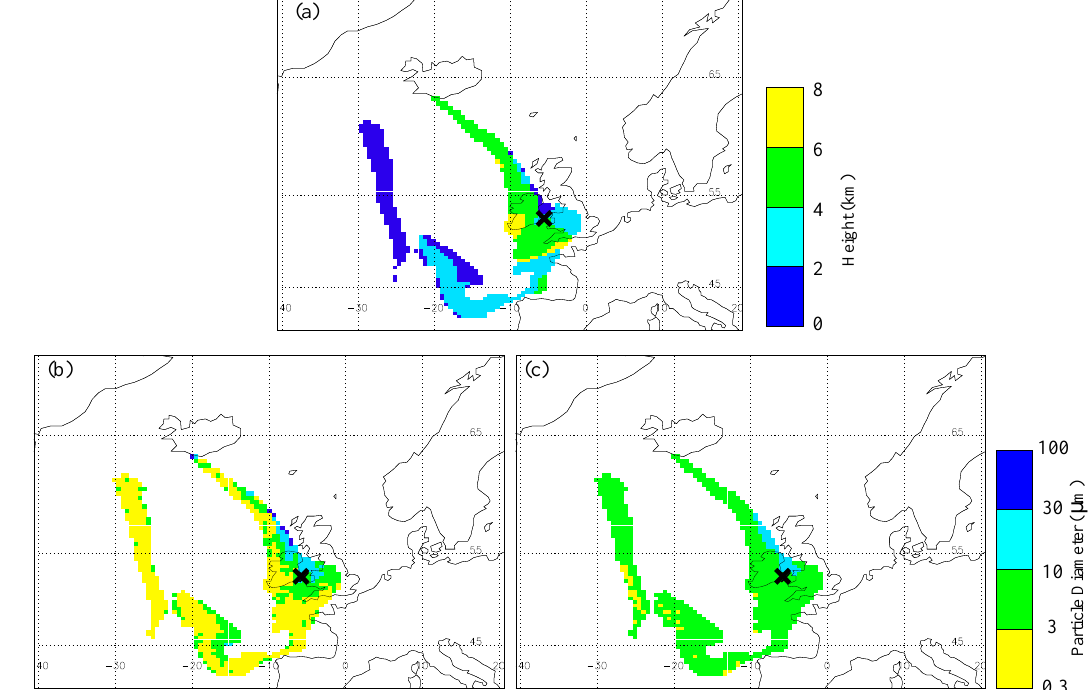
Fig. 10. (a) Height of the maximum mass concentration in each column. Mode of the particle size distribution at the height of the maximum mass concentration in NAME using (b) uniform distal particle size distribution 3 and (c) distal particle size distribution 2. 12 UTC on 5th May, the cross shows the location of the aircraft observations.